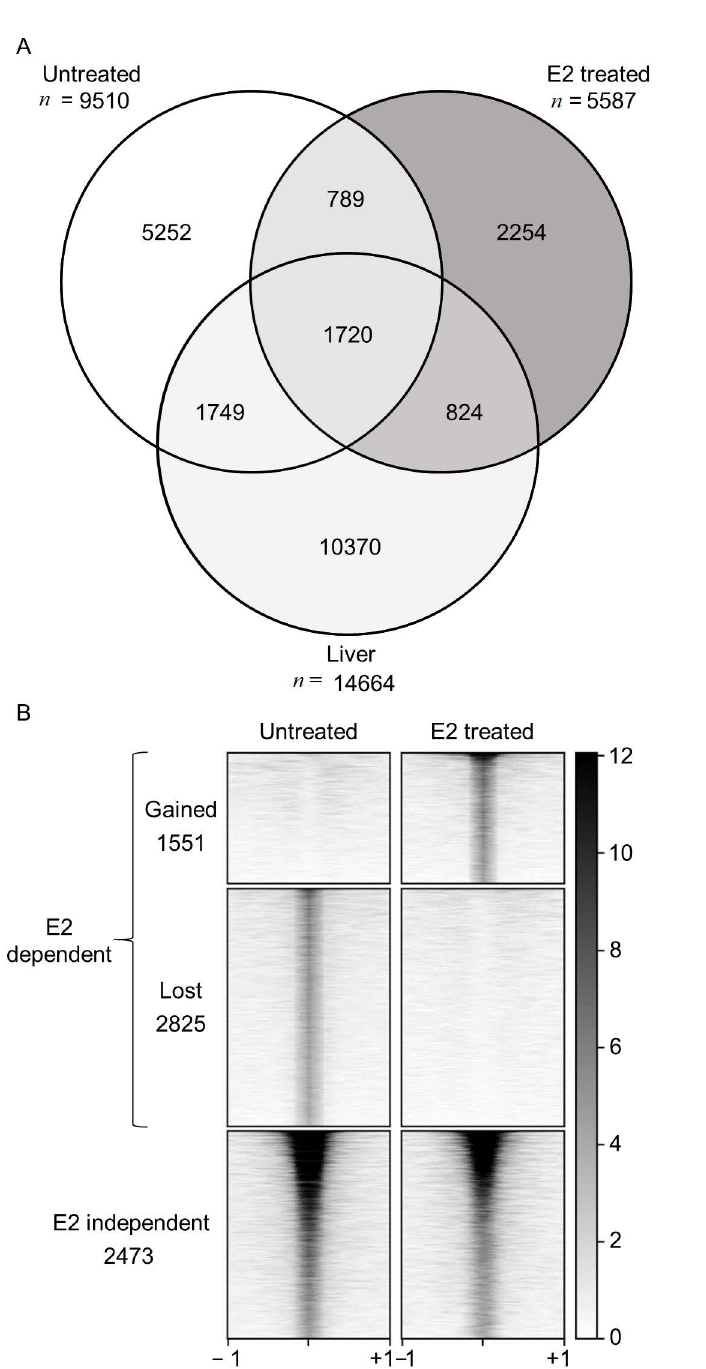
Figure 1. ESR1 ChIP-Seq peaks identified and classification of ESR1 binding in response to E2 treatment. ( A ) Venn diagram detailing peak overlap in each sample. ( B ) ChIP-seq read density heatmap showing ESR1 enrichment in each binding category. Density plots are centered on ESR1 peaks within a ± 1 kb window. Darker coloration indicates higher ChIP-Seq read